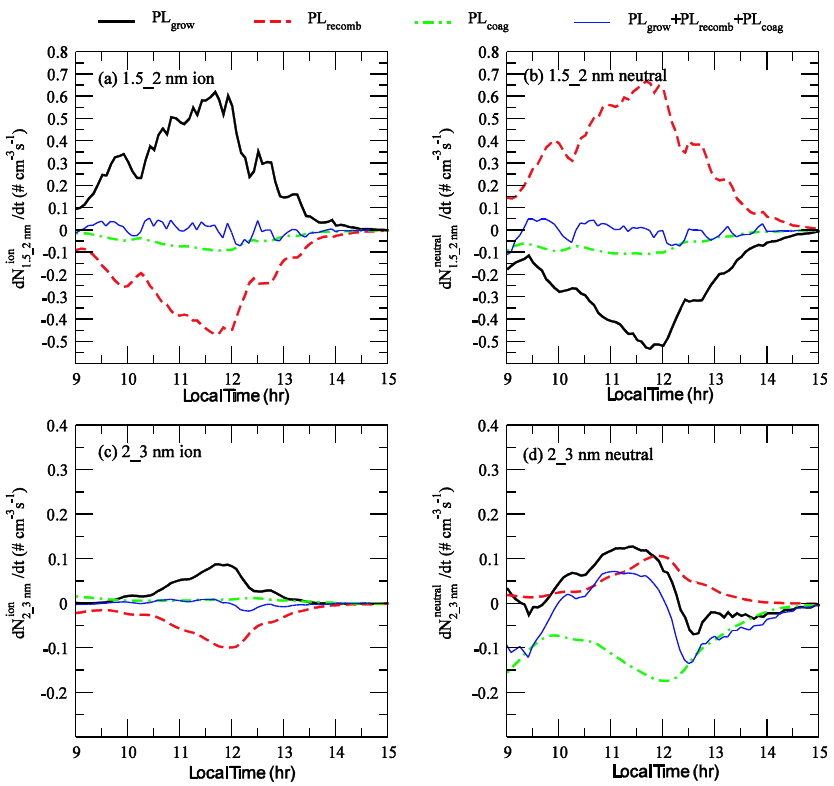
Fig. 4. The contributions of specific processes (i.e., growth, coagulation and recombination) to the changes in neutral and charged particle concentrations in the 1.5–2nm and 2–3nm size ranges (refer to Figs. 2 and 3, and the text).